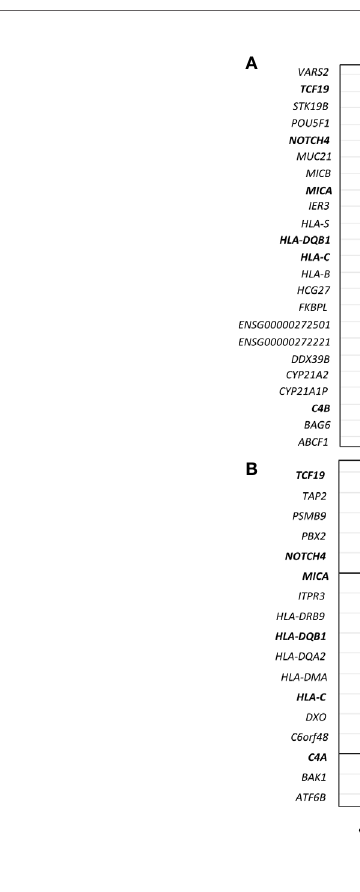
FIGURE 3 | Fine-mapping of the top loci. X-axis represents the tissue types (black indicates GI-tissue). Y-axis represent the genes. Genes that appear in both eCAVIAR and MetaXcan are in blood. (A) Colocalization of the 4 lead SNVs at the MHC region. The dot size represents the maximum CLPP values in the corresponding locus and tissues. The color represents different locus for each lead SNV. (B) MetaXcan associations of the MHC region with CDI in antibiotic subgroup. The size of the dots represents the signi fi cance of the association between predicted expression and the CDI in patients exposed to high-risk antibiotics. Red indicates positive correlation while blue negative. Darker color indicates larger genetic component and consequently more active regulation in the tissue (R 2 is a model performance measure computed as the correlation squared between observed and predicted expression, cross validated in the training set). Only associations with p<0.01 were